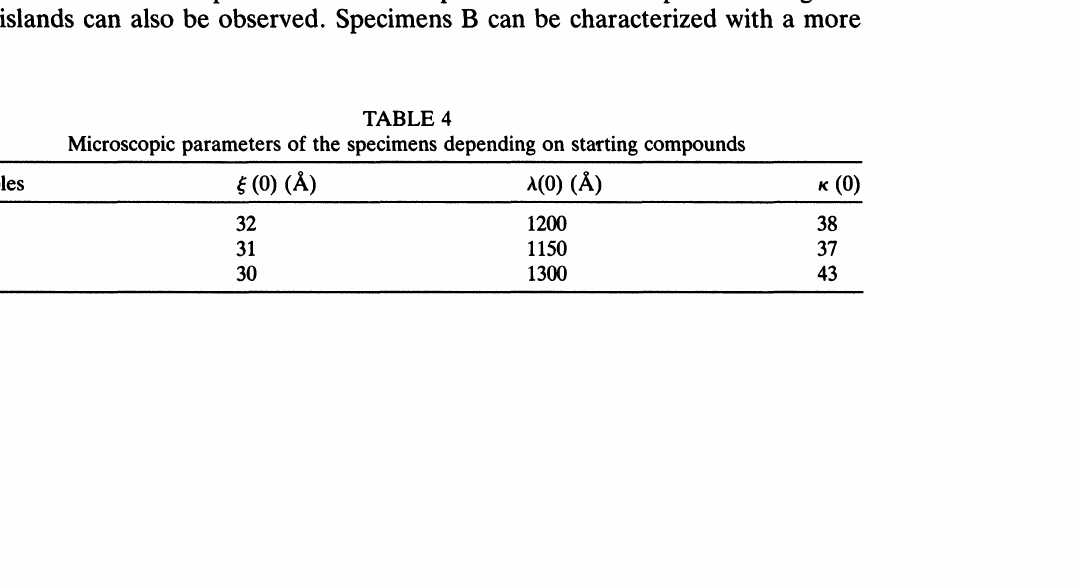
Microscopic parameters of the specimens depending on starting compounds